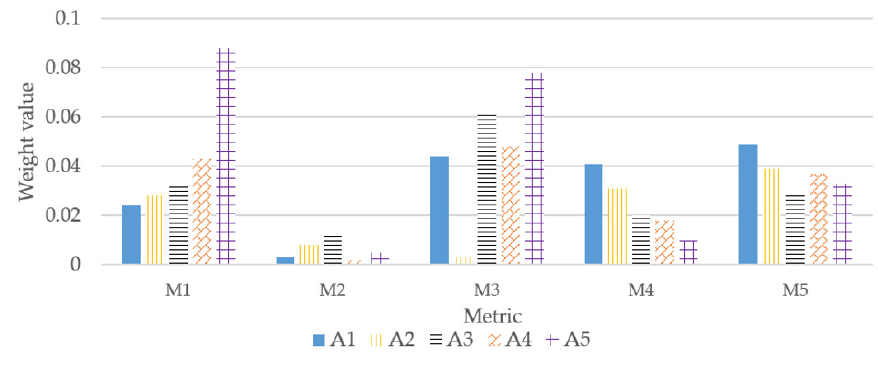
Figure 11. Result of weight.